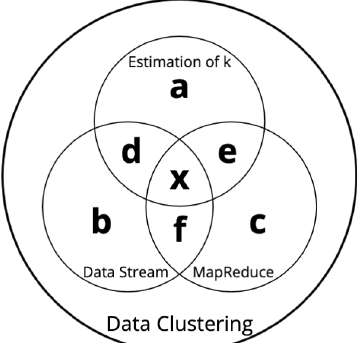
Figure 1. Relationship between the main data clustering sub-fields: estimation of the number of clusters k ( a ), data stream ( b ), and MapReduce ( c